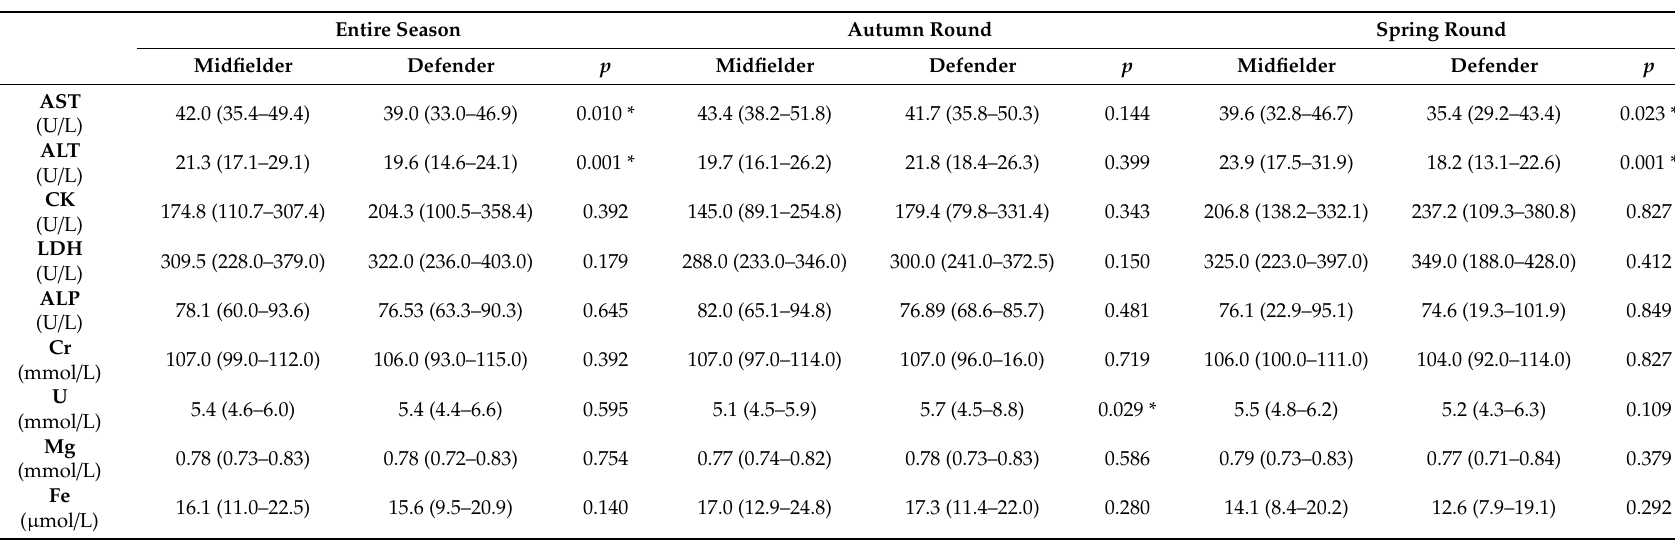
Table 4. Comparison of the midfielder and defender subgroups in terms of selected plasma biomarker values during the soccer match season. Entire Season Autumn Round Spring Round Midfielder Defender p Midfielder Defender p Midfielder Defender